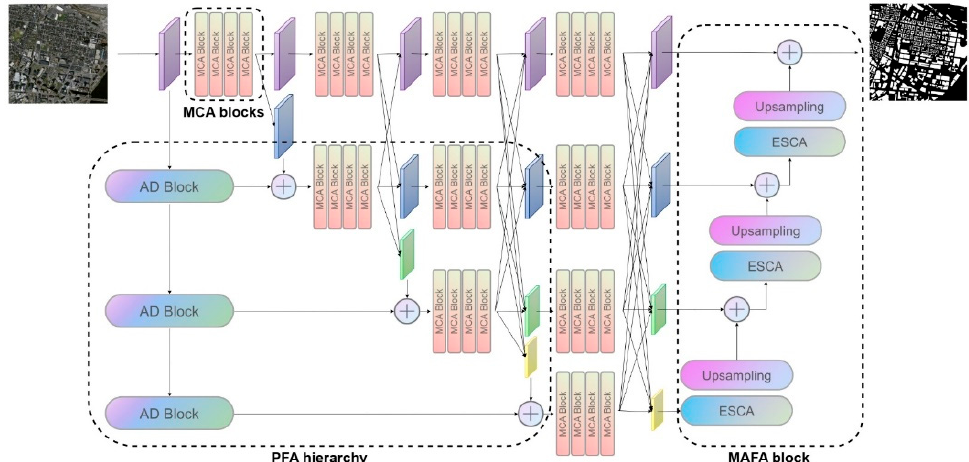
Figure 1. Structure of the MAFF-HRNet model. Our model uses a parallel construction instead of a serial construction to generate four feature maps of different resolutions. We incorporate a PFA hierarchy (details in Section 2.2) into the original HRNet by adding the attention downsampling (AD) blocks. In addition, we further add MCA (details in Section 2.3) and MAFA (details in Section 2.4) blocks into the model to boost the capture range of the receptive fields and retain more detailed features, so as to obtain more accurate segmentation results.